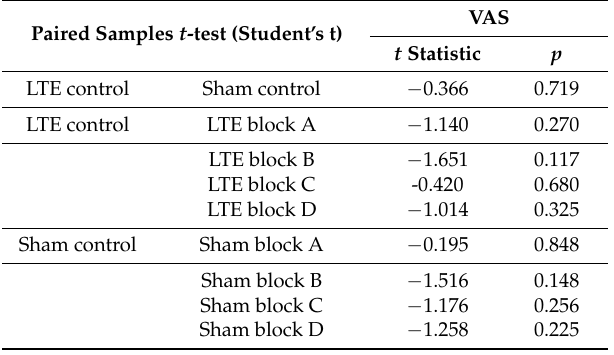
Table 2. Results of paired samples t -tests of subjective pain ratings assessed using the Visual Analogue Scale (VAS) for each experimental